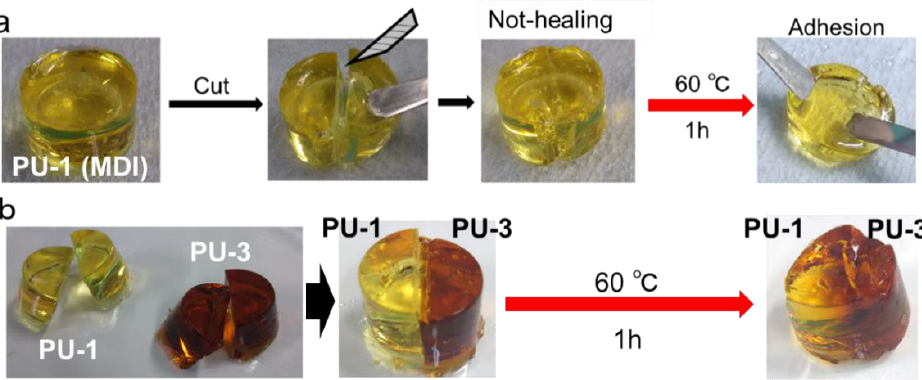
Figure 4. Self-healing of cross-linking PU gels by a Diels-Alder reaction. ( a ) Self-healing of notch on PU-1 gel surface by heat, ( b ) Self-healing and adhesion between cross-linking PU-1 and PU-3 gels.